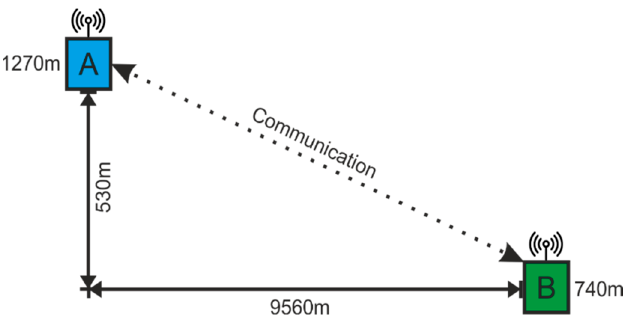
Figure 12. Orographic conditions of the range test.